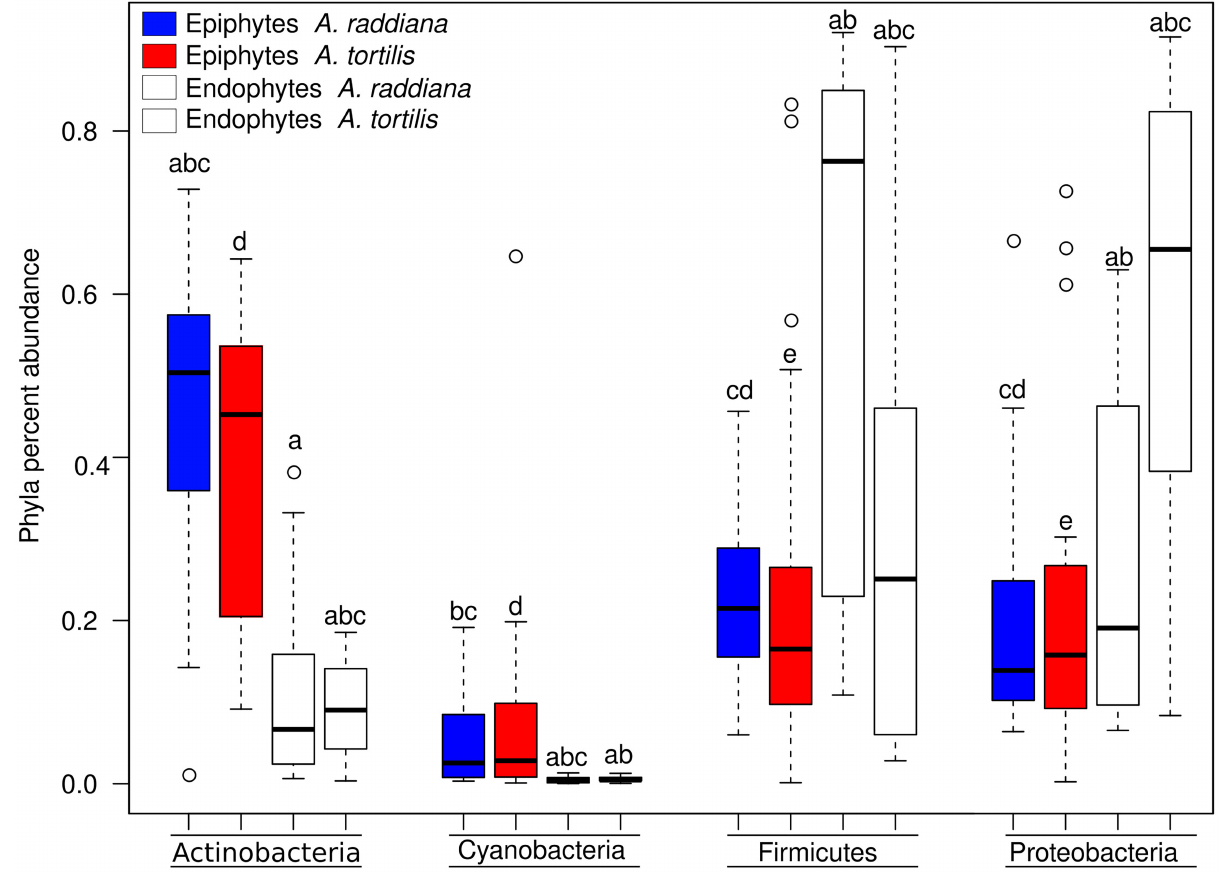
FIGURE 3 | Box plot illustrating the percent abundance of epiphyte and endophyte major bacterial